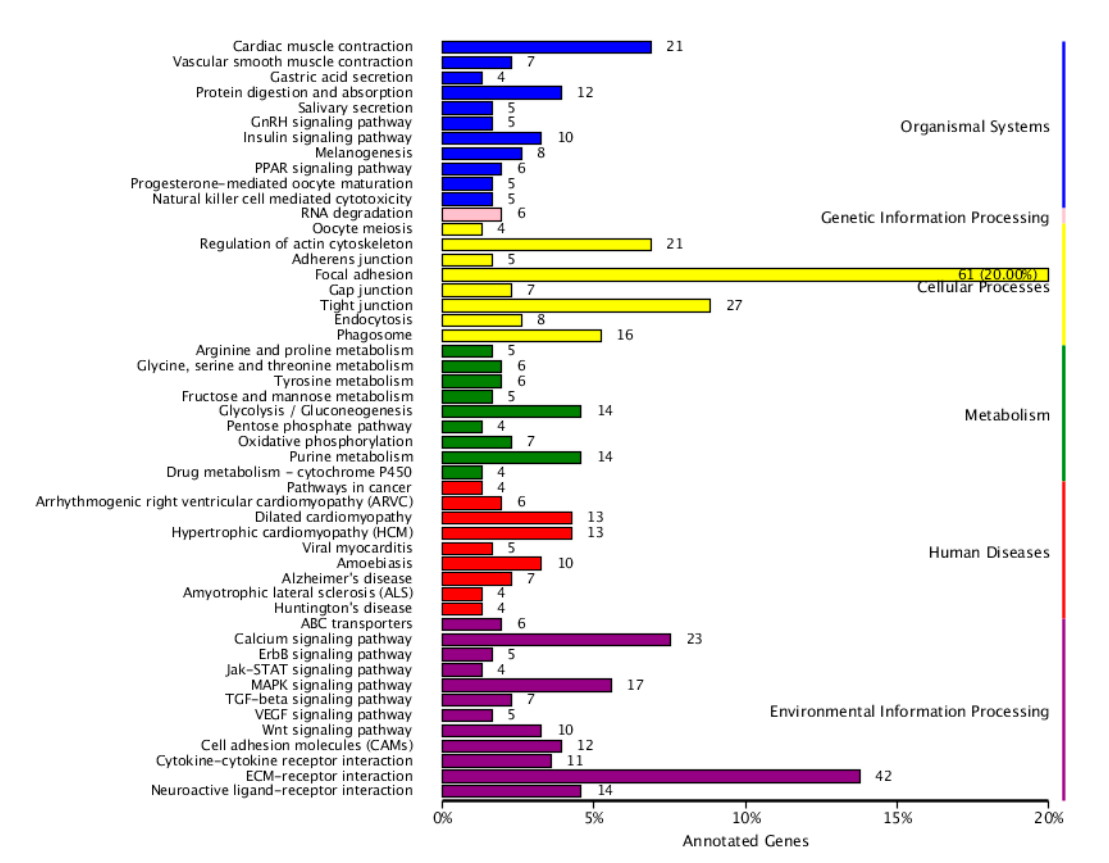
Figure 5. COG function classification of differentially expressed genes in YL and GY skin color of A. davidianus . The horizontal coordinate is the classification content of COG, and the ordinate is the number of genes. In different functional categories, the proportion of genes reflects metabolic or physiological preferences in the corresponding period and environment, which can be explained scientifically based on the distribution of research objects in each functional category.